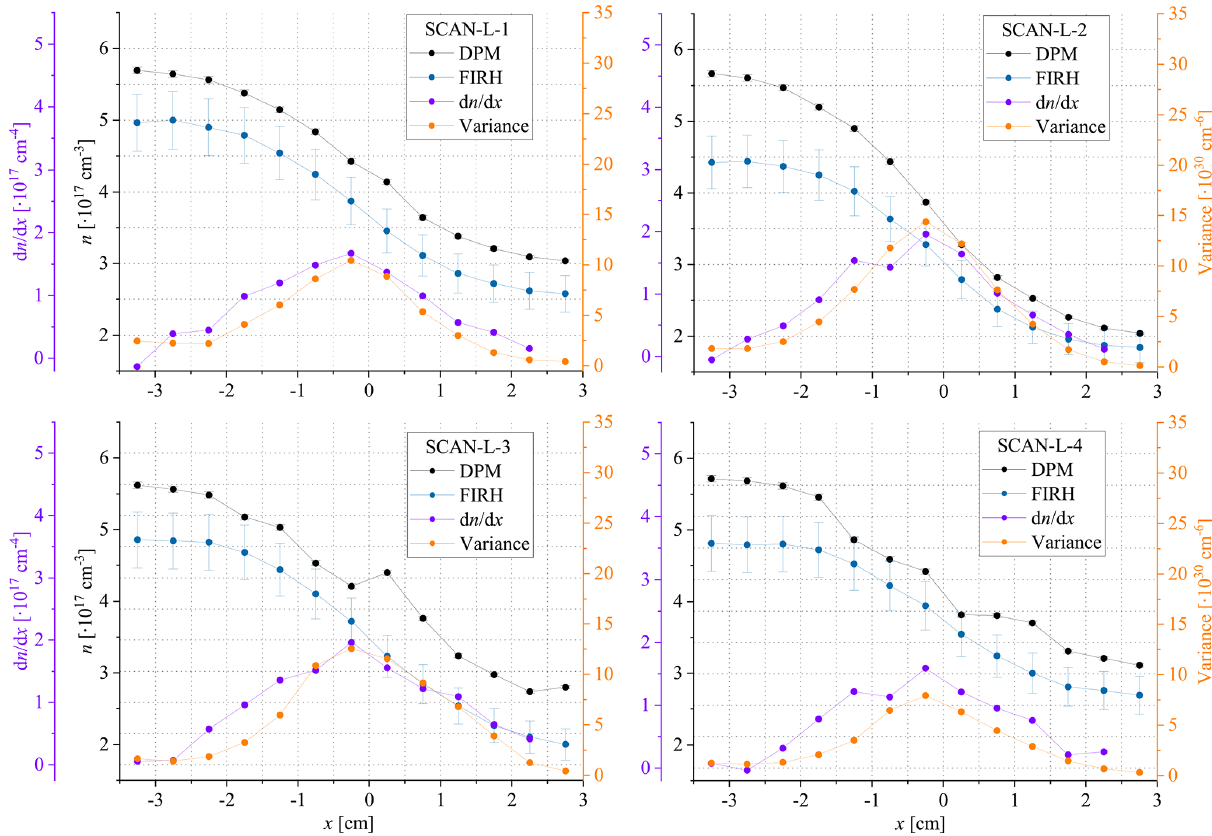
Figure 8. Turbulent mixing of the two streams differing in thermodynamic properties (given in Table 1) observed in the course of the four experiments: the profiles of mean n and its variance and gradient d n/ d x with respect to the position x .